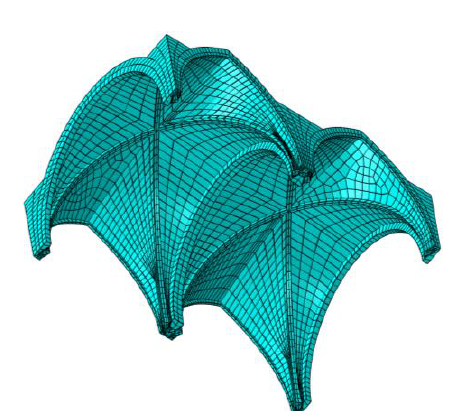
Figure 8. Vaults in the nave of the church of St. Bassiano: Mesh with hexahedral elements for numerical simulations